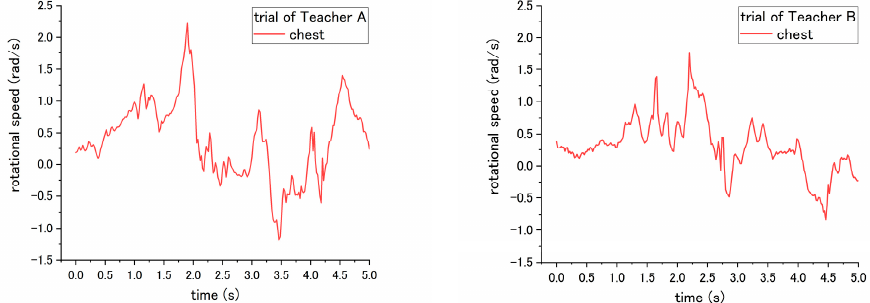
Figure 13. Rotational speed of patient’s chest during step No. 12 when the incorrect way was conducted at step No. 9.